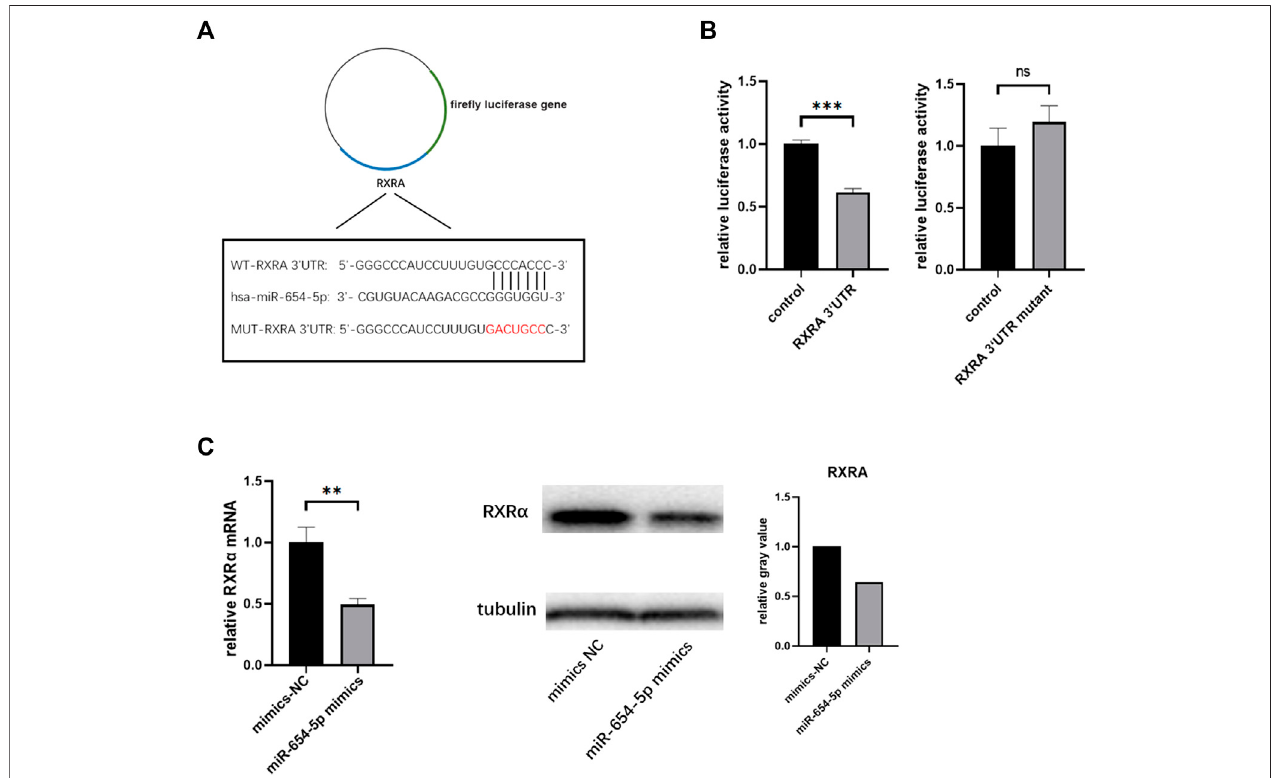
FIGURE 4 | RXR α serves as a direct target of hsa-miR-654-5p. (A) Binding region between hsa-miR-654-5p and RXR α , and the luciferase reporter constructs containing the WT-RXR α or MUT-RXR α sequence (B) WT-RXR α or MUT-RXR α were co-transfected into HEK-293T cells with the hsa-miR-654-5p mimic or the correspondingnegativecontrol (C) RXR α mRNAandproteinexpressionlevelsinLX-2cells.GreyvaluesaremeasuredthroughImageJ.Cellsweretransfectedwiththehsa-miR-654- 5p mimicor their correspondingnegativecontrols. Error barsrepresentmean ±SEMofatleastthreeindependent experiments. ** p < 0.01,*** p < 0.001; ns, p > 0.05. MUT, mutant; WT, wild